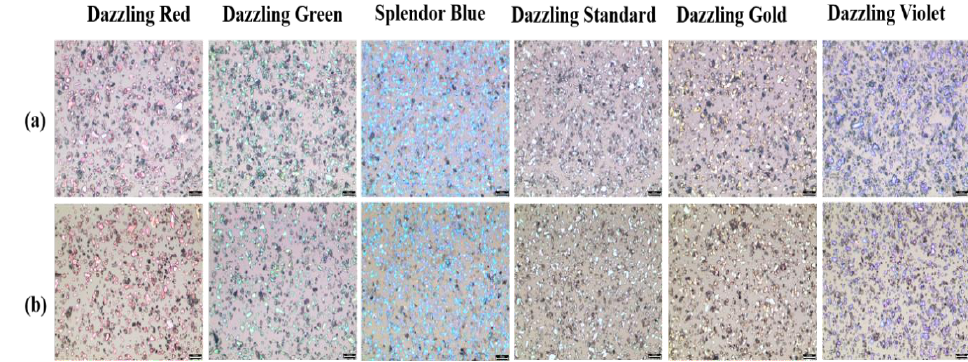
Figure 5. Optical microscope images of thin colored films spin-coated at ( a ) 1500 rpm and ( b ) 3000 rpm. ( b ) 3000